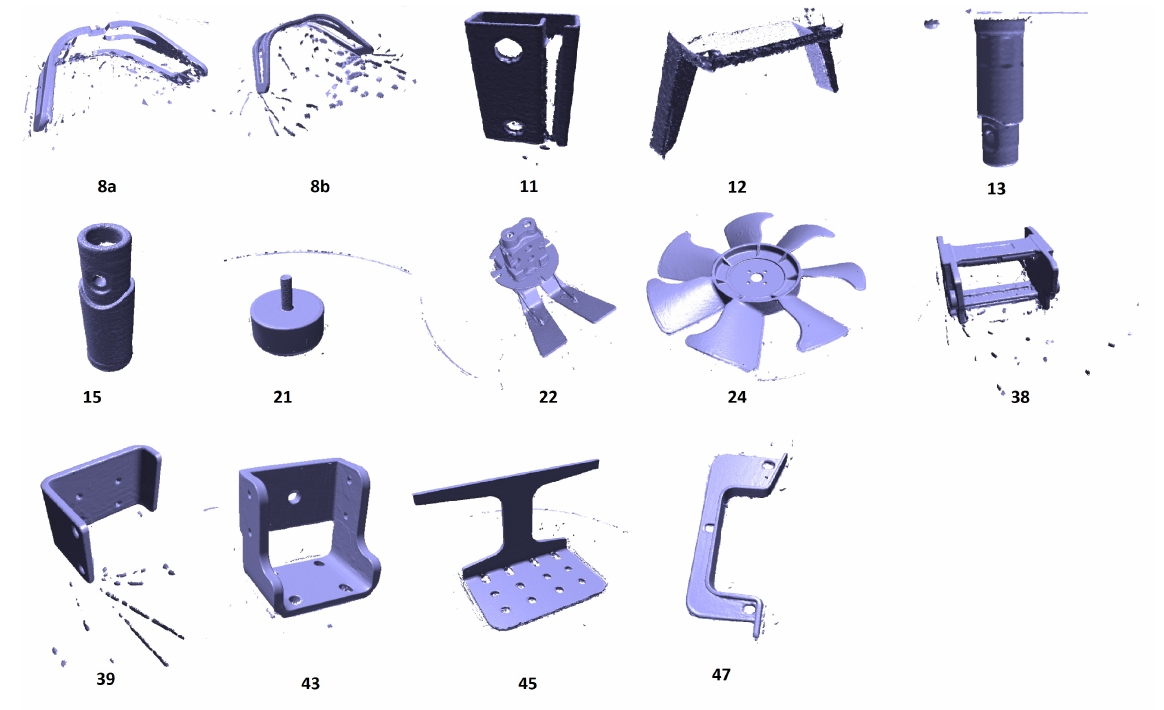
Figure 10. Scans of the mechanical components from Figure